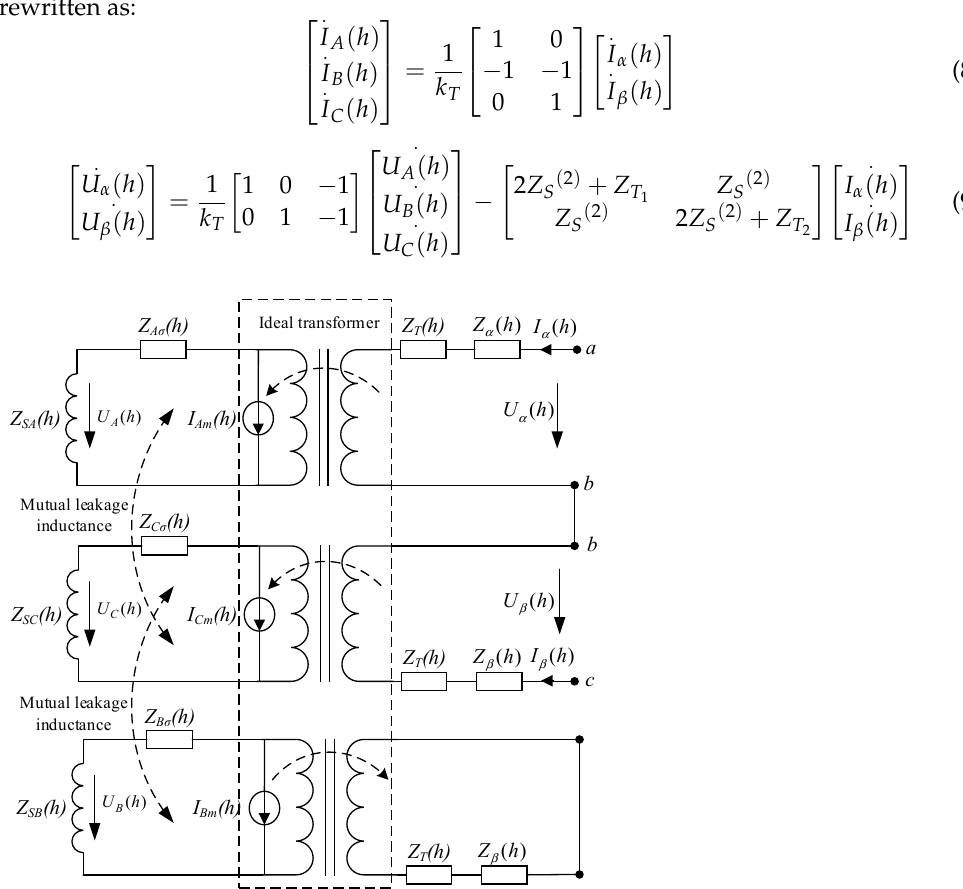
( b ) Figure 6. ( a ) D/y n transformer wiring diagram; ( b ) phasor diagram. The electrical coupling relationships of the primary and secondary sides are ex- pressed as: